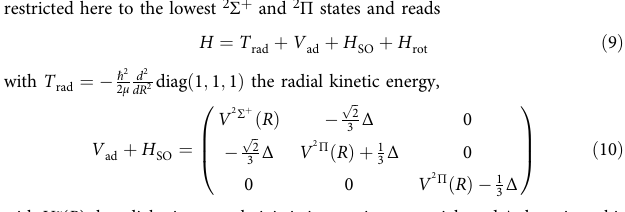
q ffiffiffiffiffiffiffiffiffiffiffiffiffiffiffiffiffiffiffiffiffiffiffi Þ (cid:3) J ð J þ 1 Þ (cid:3) 3 4